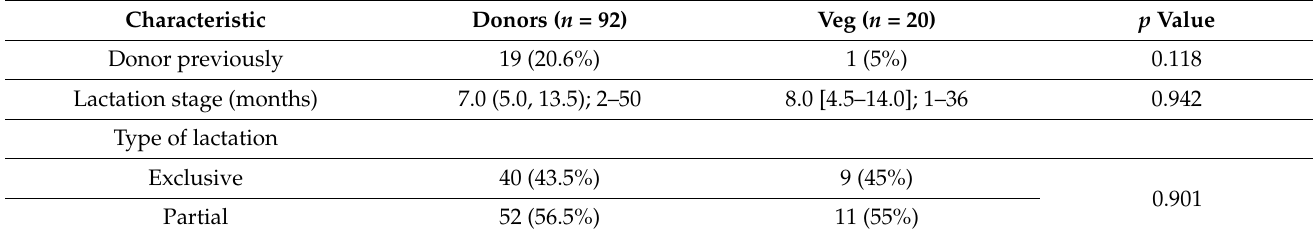
Table 3. Characteristics of the lactation of the omnivore human milk donors with full-term infants (Donors) and vegetarian/vegan lactating mothers